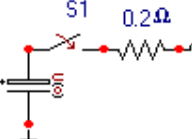
Figure 7. LCG300S impulse current generator.